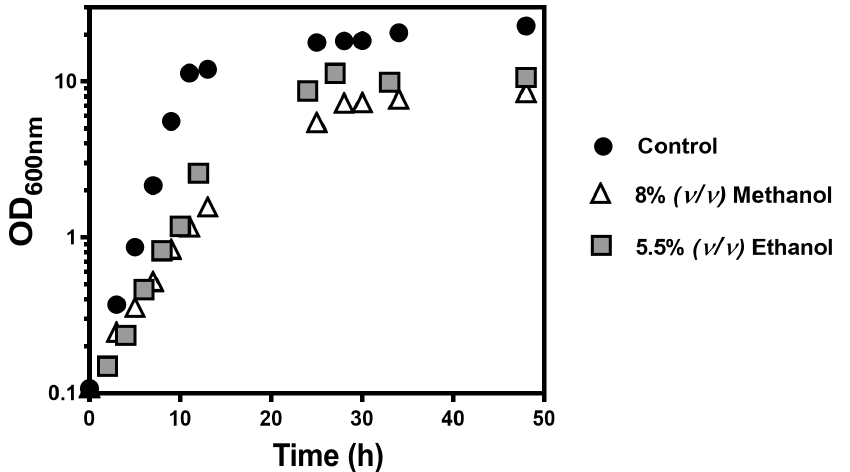
Figure 2. Effect of equivalent methanol and ethanol concentrations in the growth curves of S. cerevisiae BY4741. Cells were cultivated in liquid YPD medium (pH 4.5) supplemented, or not (circles), with 8% ( v / v ) methanol (triangles) or 5.5% ( v / v ) ethanol (squares) at 35 ◦ C with orbital agitation (250 rpm). Growth was followed based on culture optical density at 600 nm (OD 600nm ) and the growth curves shown are representative of at least three independent experiments.